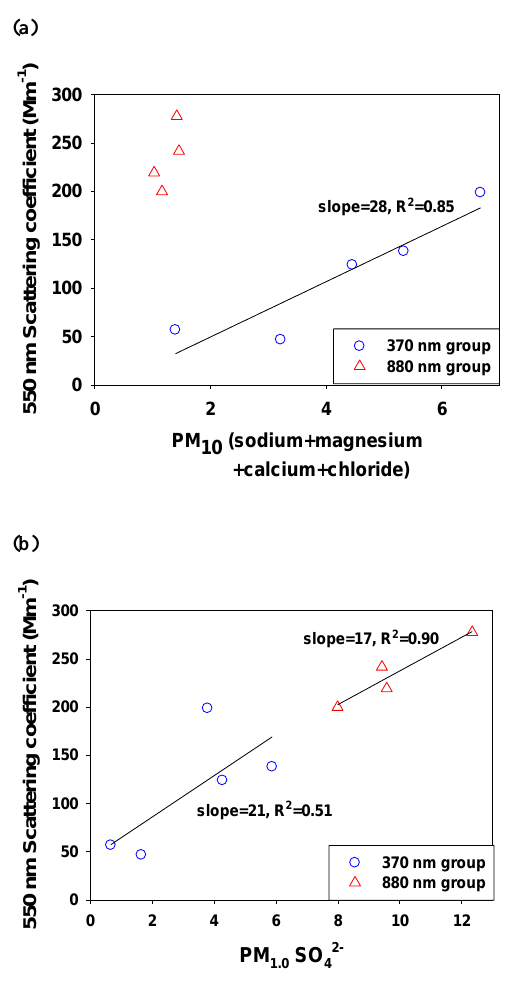
Figure 2. (a) Correlation of PM 10 (Na + + Ca 2+ + Mg 2+ + Cl - ) with 550 nm scattering coefficient. (b) Correlation of PM 1.0 sulfate with 550 nm scattering coefficient. Scattering coefficient data obtained by nephelometer were collected at 10-minute intervals, and were averaged for each day to be compared with our observed PM data. Lines show linear regressions, for which slopes and R 2 values are given.